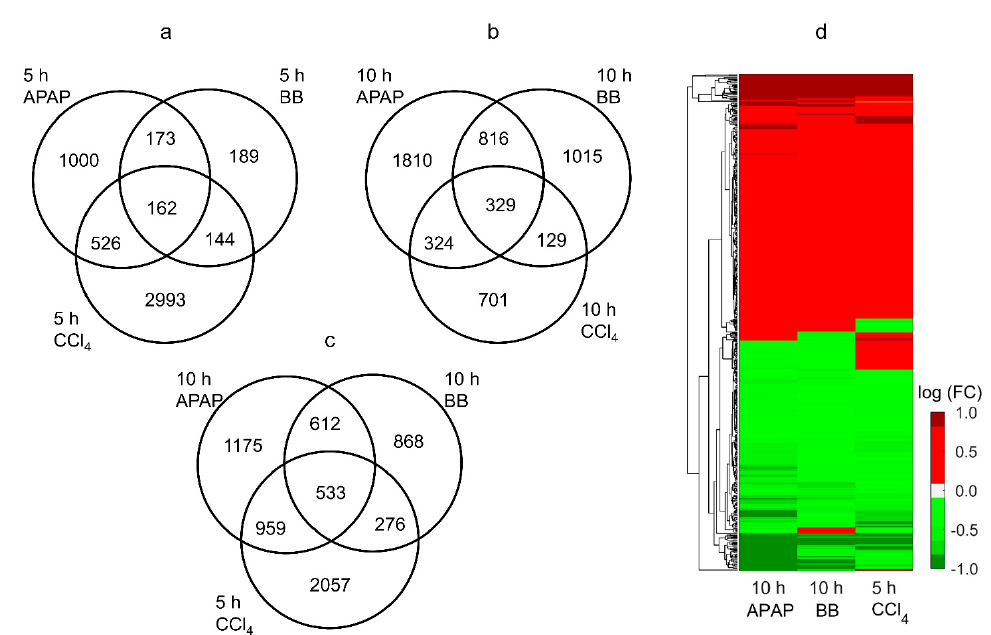
Figure 3. Venn diagrams depicting the commonalities among the significantly changing gene expressions for all three toxicants (APAP, BB, and CCl 4 ) at ( a ) the 5 h time point, ( b ) the 10 h time point, and ( c ) based on the time point at which peak gene expression alterations were observed for each toxicant. ( d ) Heat map of the significantly (FDR < 0.1) altered common genes in the liver based on the peak alteration time points for each toxicant. Red and green bars indicate up- and down-regulated genes, respectively.